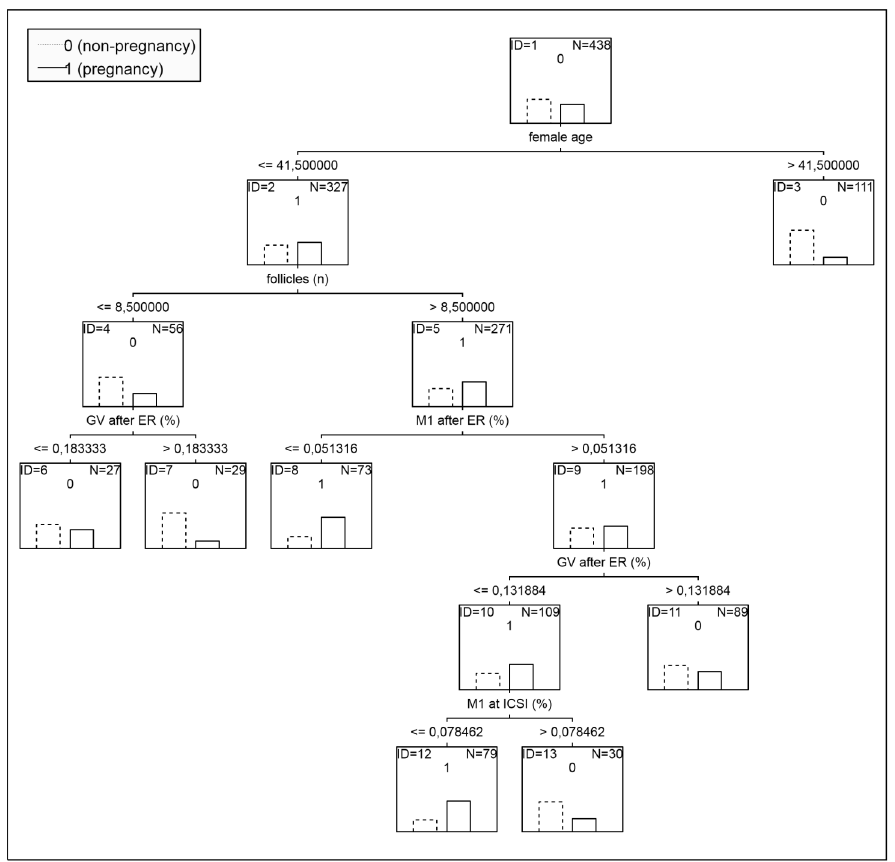
Figure 2. Classification tree constructed with variables relating to the women’s ages and number and quality of oocytes obtained by the stimulation 43.5 years, 7 cell on day 3 above 13.8%, retrieved oocytes at least 3 and ≥ M2 after ER over